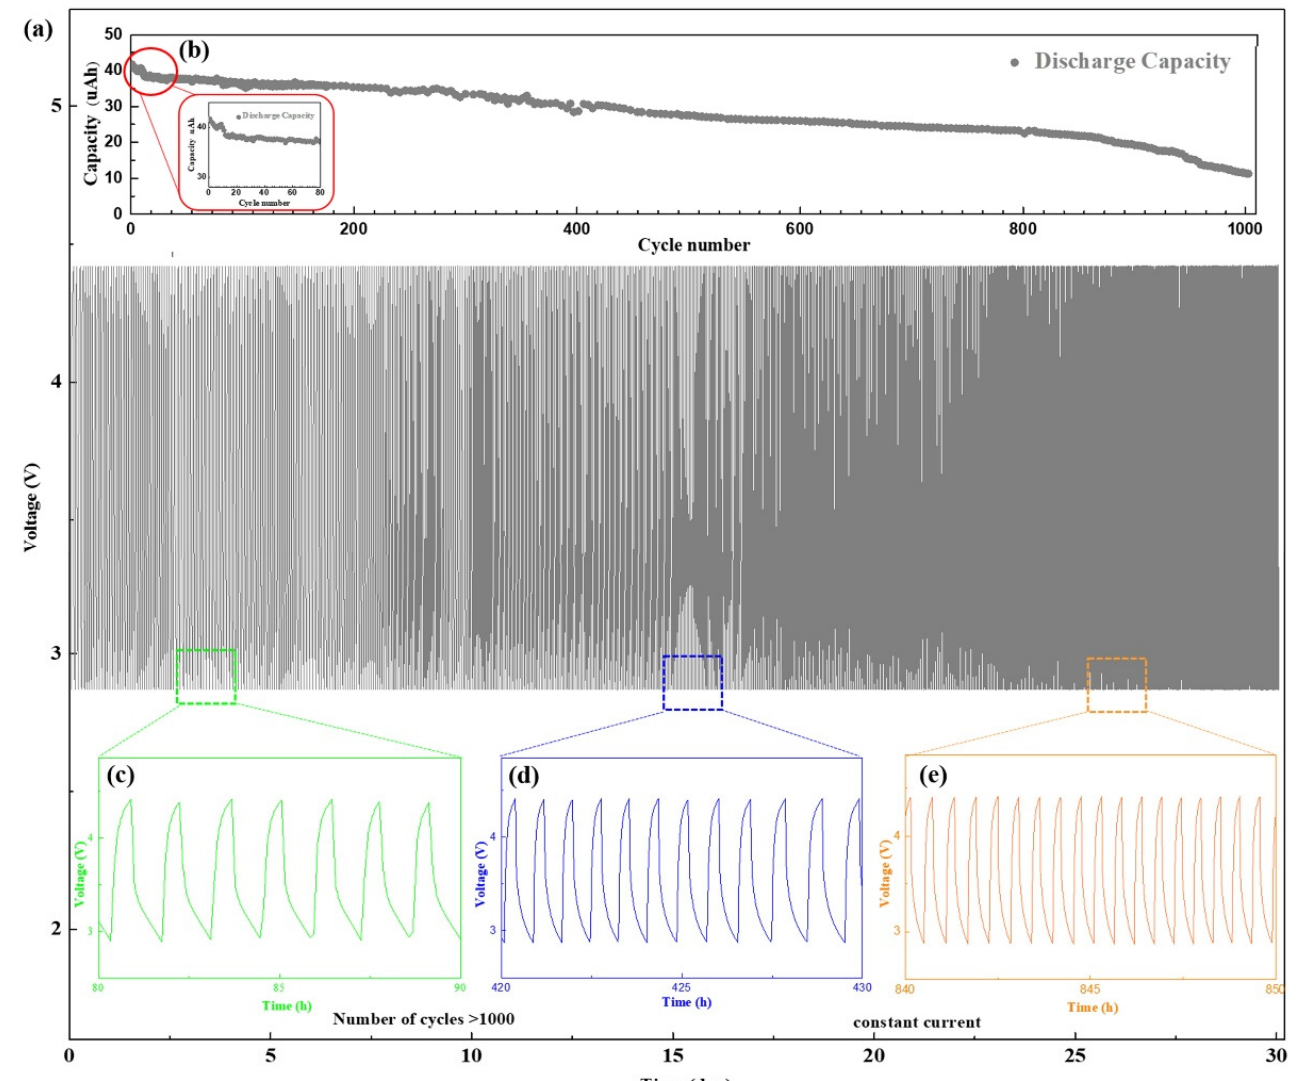
Figure 5. Cycling performance of the battery with NCM/SiO 2 /LLTO structure, which was measured with a constant current 3 µ A with a cycling potential range from 2.8 to 4.2 V. ( a ) Charge/discharge curve of the battery (1000 cycles). ( b ) Cycle performance of the discharge capacity of the battery. Charging/discharging curves of the battery from the ( c ) 80th to 90th cycles ( d ) 420 to 430 cycles. ( e ) 840 to 850 cycles.